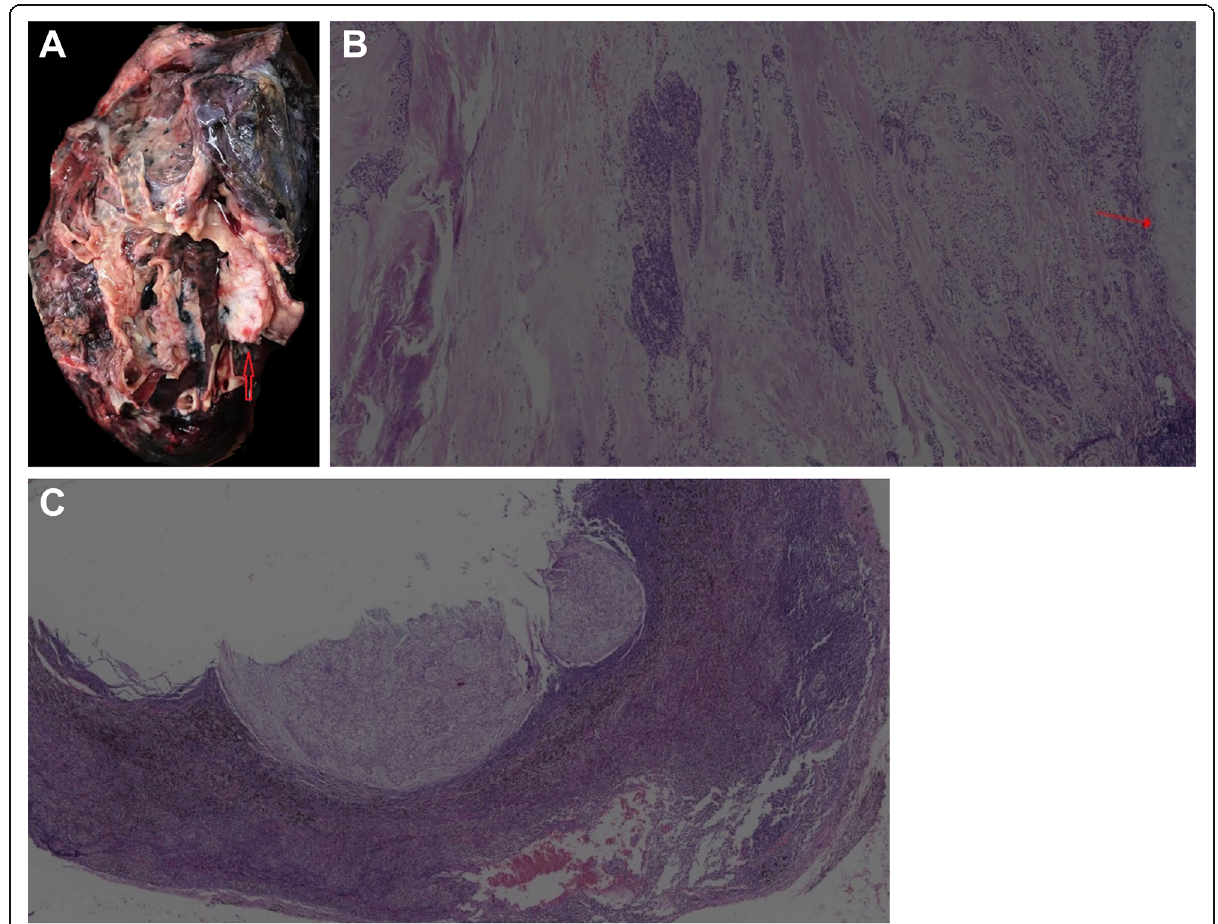
Fig. 4 A The cut surface revealed a firm, solitary, well-circumscribed, 2.8-cm tan mass, 1.0 cm from the bronchial margin (red arrow). B Atypical small-to-medium sized epithelioid cells with light eosinophilic to clear cytoplasm embedded in a hyalinized stroma (the red arrow indicates bronchial cartilage). C The tumor cells that had metastasized to the lymph nodes showed the same morphology as the primary